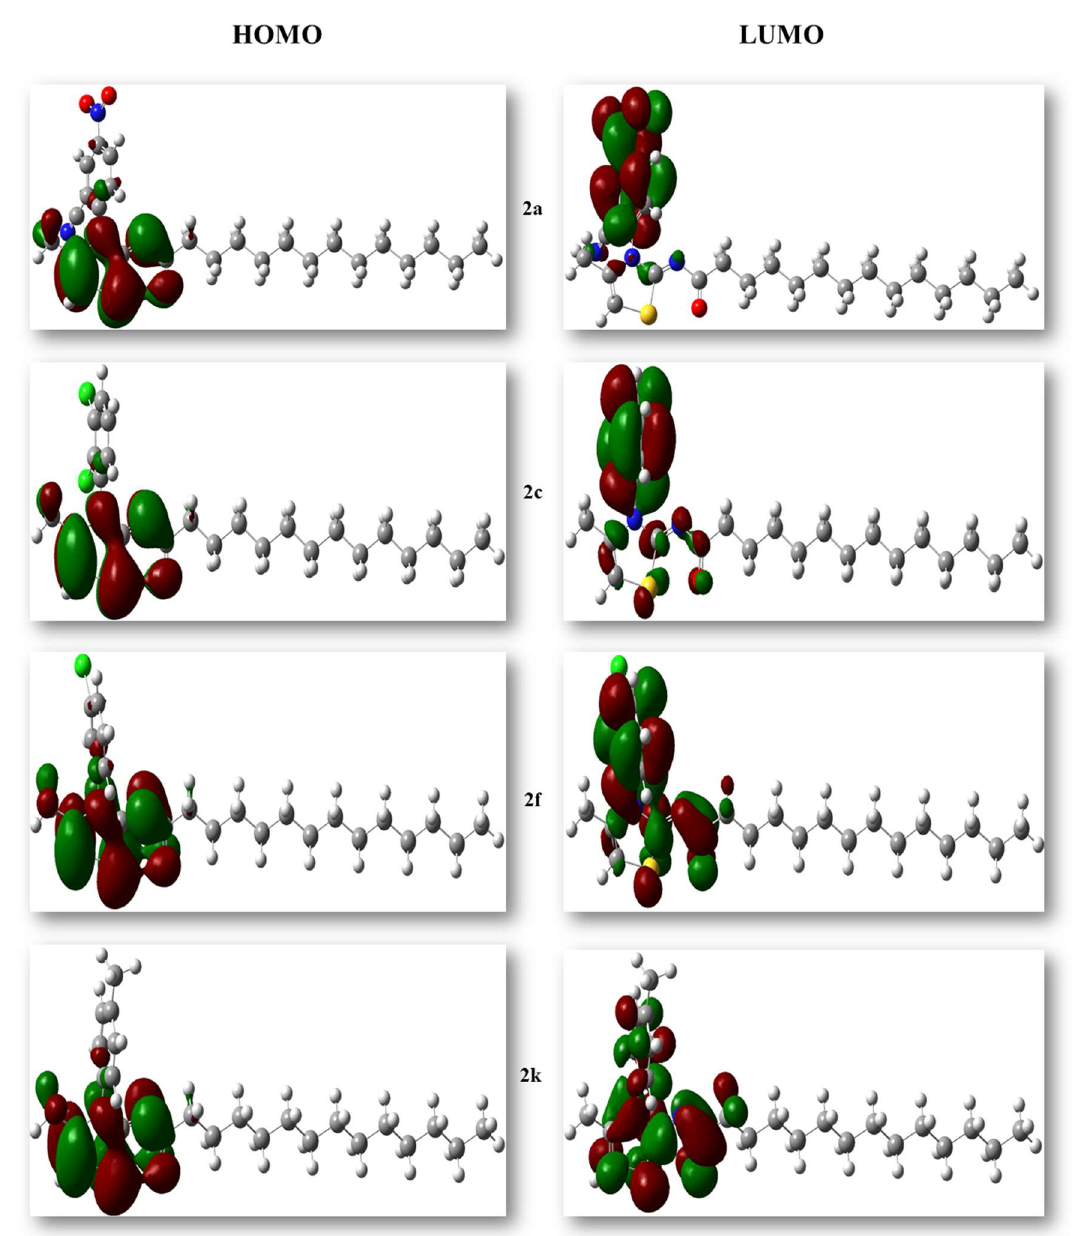
Figure 5. HOMO–LUMO orbitals ( 2a , 2c , 2f , 2k ). Red, yellow, and blue atoms indicate O, S, and N atoms.